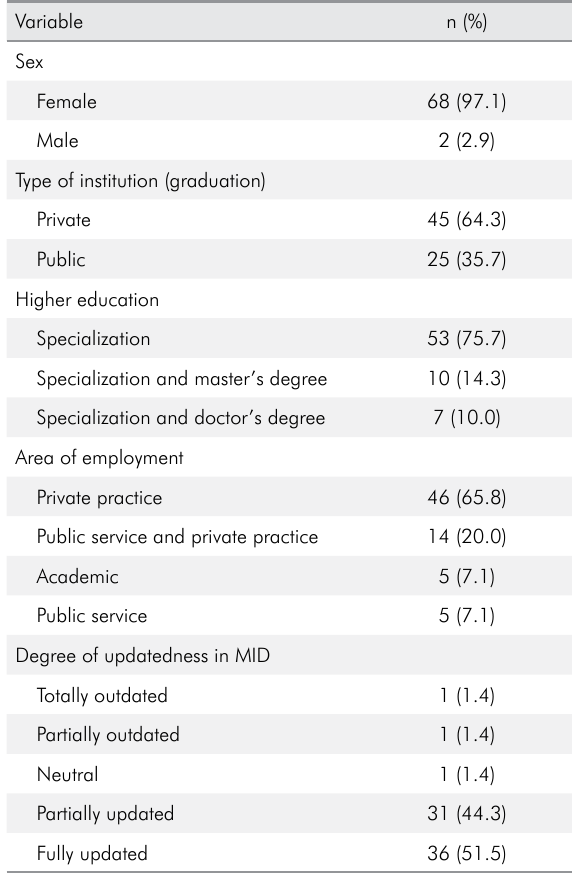
Table 1. Characteristics of the